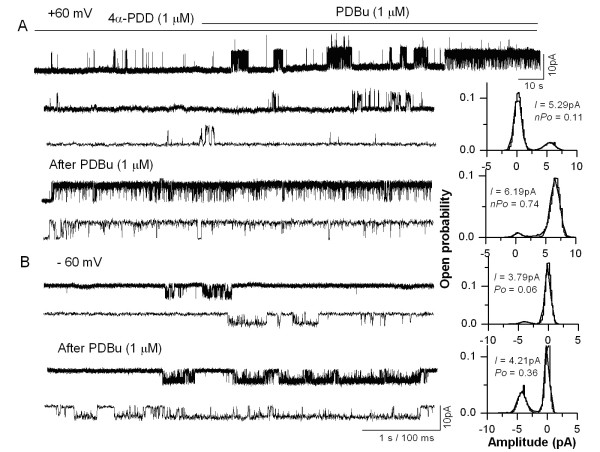
Enhancement of TRPV4-mediated single-channel current activity by PKC. A. Single-channel currents activated by 4α-PDD (1 μM) recorded at + 60 mV from a cell-attached patch on TRPV4 transfected HEK 293T cells before and after PDBu incubation. The traces are shown at higher time resolution below and the amplitude histograms are shown on the right. B. 4α-PDD-induced single-channel currents recorded at – 60 mV before and after PDBu incubation. The traces are shown at a higher time resolution below and the amplitude histograms are shown on the right.